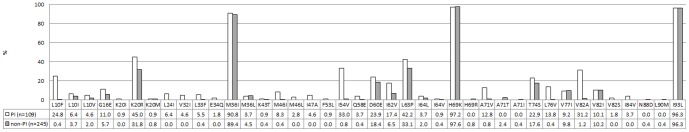
Protease Inhibitor mutation profiles.Mutation profiles associated with failure to PIs are depicted in white, mutation profiles associated with failure to non-PI-based regimens are depicted in grey. The numbers represent percentages.